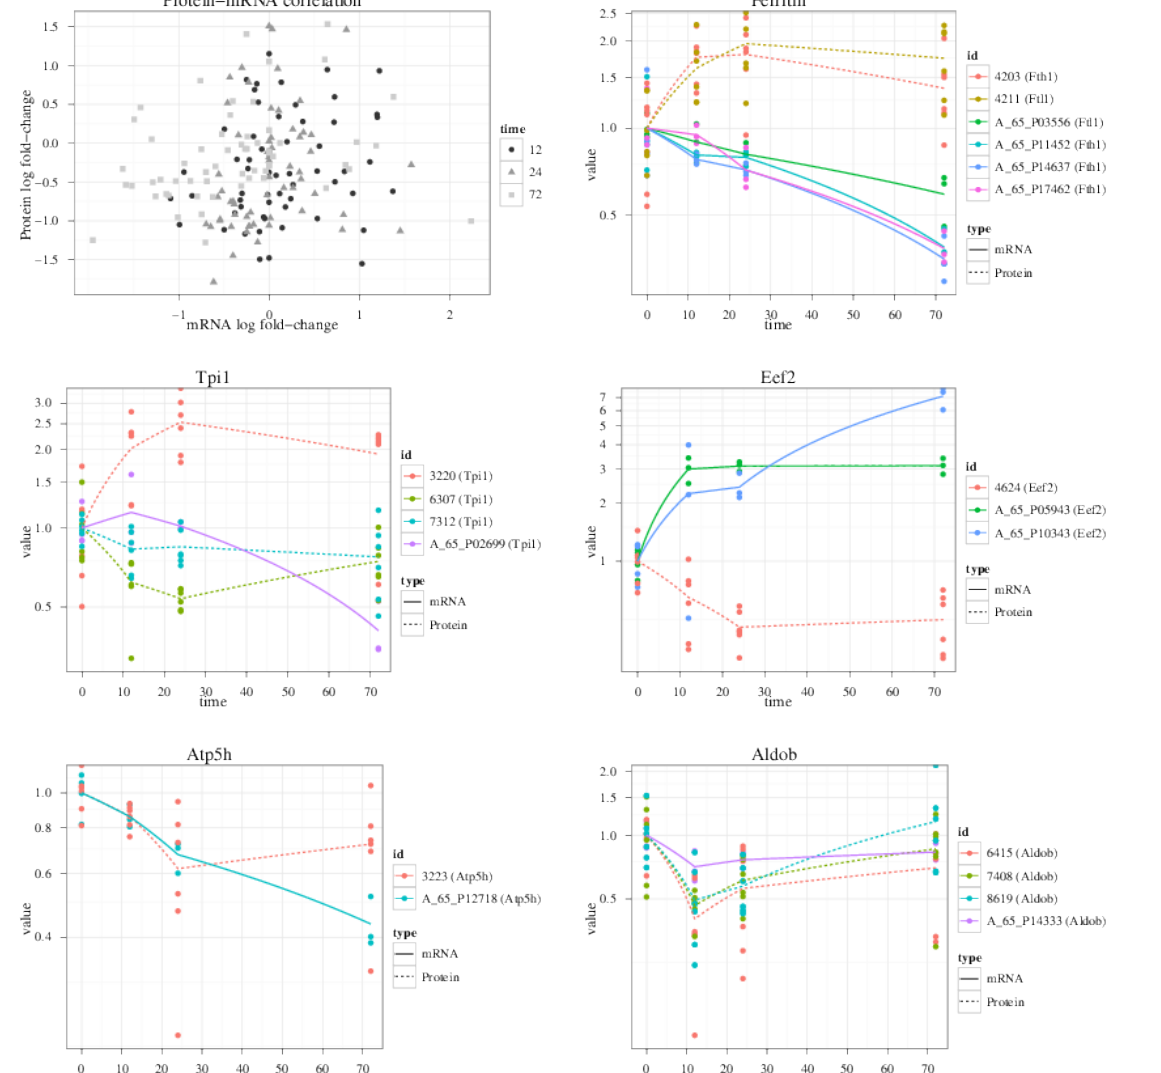
Figure 1: Combined mRNA and protein expression plots. In the top-left plot, the fold-change of protein and mRNA expression are plotted against each other. Fold-changes are calculated for each time point against t=0. In cases where multiple protein spots correspond to the same gene, the average was used. The overall correlation plot shows that there was very little agreement between protein and gene expression. The five other plots show individual genes in detail. Each dot represents a measurement of a spot or probe. Lines connect the average of each probe or spot per time point. Solid lines represent transcripts, dashed lines represent proteins. The average intensities at 0 hours have been normalized to 1; all other values are relative to this average. Top-right: Ferritin heavy ( Fth1 ) and light chain ( Ftl1 ), showing opposite trends for transcript and protein expression levels. Center-left: Triose phosphate isomerase ( Tpi1 ), which is down-regulated at 72 hours with the exception of one protein spot. Center-right: Elongation Factor 2 ( Eef2 ), an example of a gene that shows opposite effects of fasting on transcript and protein expression. Bottom-left: ATP synthase D chain ( Atp5h ) and bottom-right: fructose biphosphate aldolase B ( Adlob ), are examples of two genes that show good correlation between protein and transcript